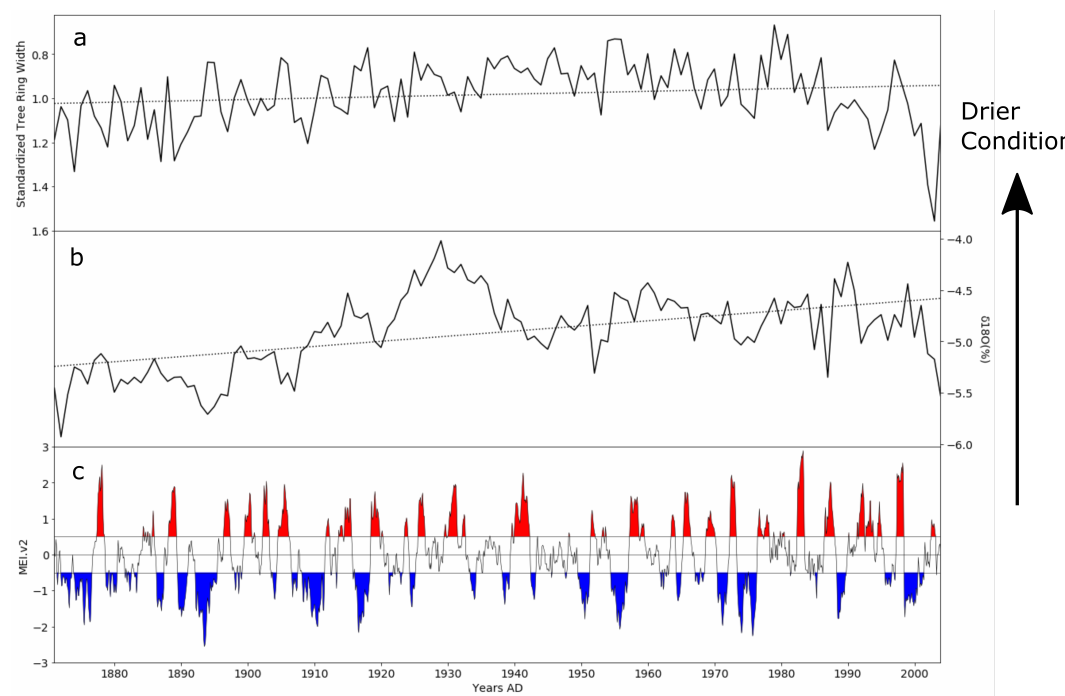
Figure 3. A plot comparing historic ENSO events to climatic proxies. ( a ) Standardised Tree Ring Width [29] (R 2 = 0.02). ( b ) Stalagmite δ 18 O values [31] (R 2 = 0.27). ( c ) The MEI.v2 ENSO index (sourced from: https://www.esrl.noaa.gov/psd/enso/mei/) spanning 1871 to 2009. Red shading highlights El Niño events (>0.5), and blue shading depicts La Niña events (< − 0.5).Trendlines are present to